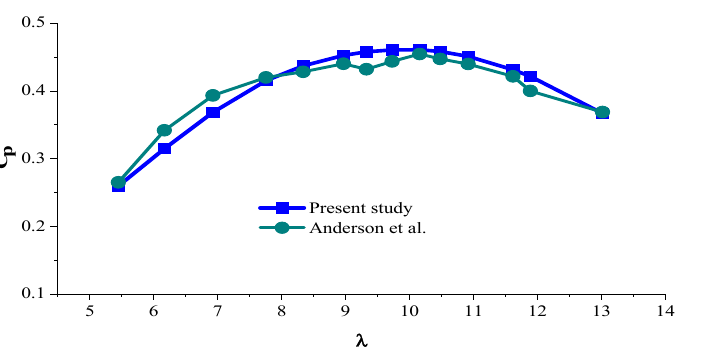
Figure 5. The variations in the drag and lift coefficients of the NACA4412 profile [10].